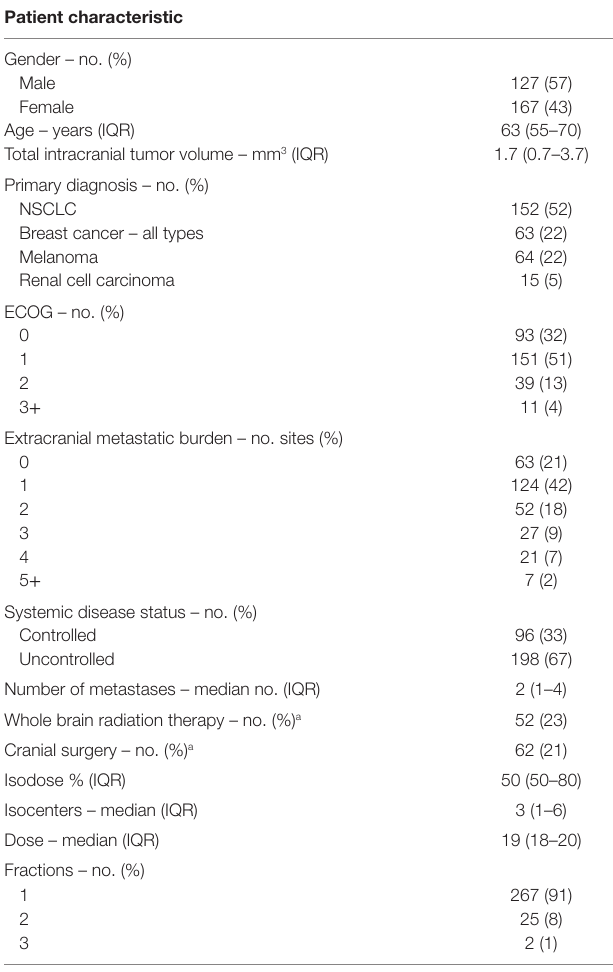
TaBle 1 | Baseline characteristics of patients and treatments with newly diagnosed brain metastases. Patient